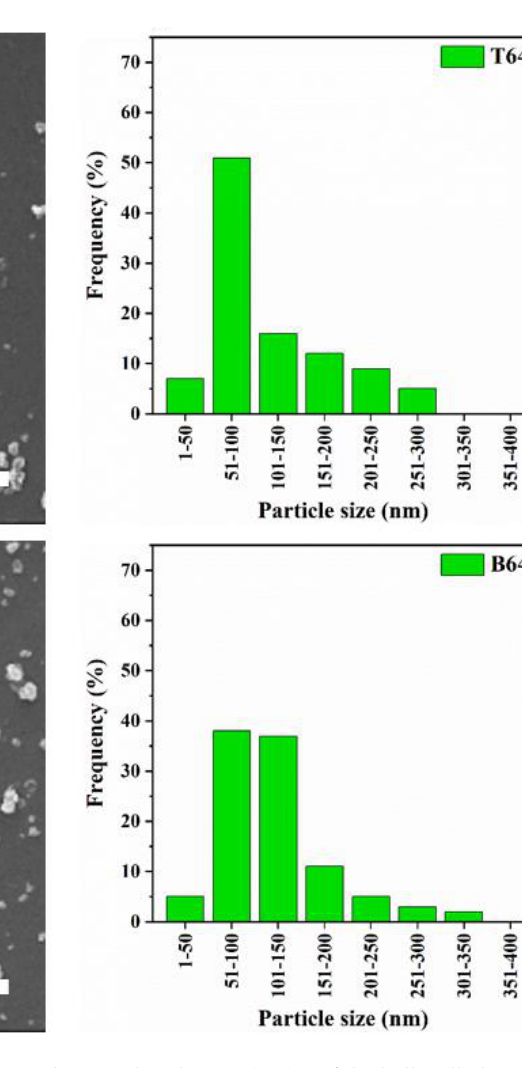
Figure 5. SEM images (left) and particles size distribution (right) of the ball-milled sample of zeolite Y: CNF = 6:4.